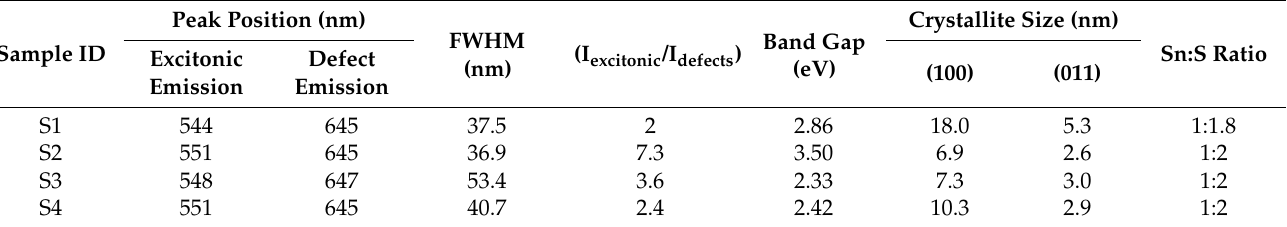
Table 3. PL peak positions, FWHM, intensity ratio (I excitonic /I defects ), band gap, and crystallite size of SnS 2